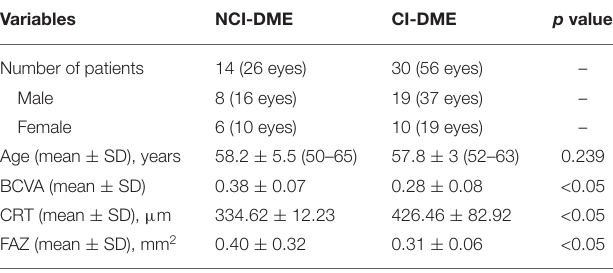
TABLE 1 | Baseline characteristics of participants.